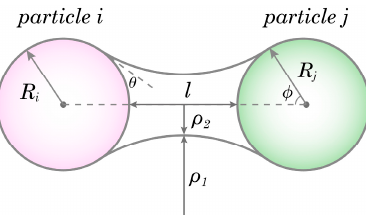
Figure 3. A schematic of meniscus liquid bridge between two particles . Adapted from [101] permitted by John Wiley and Sons.